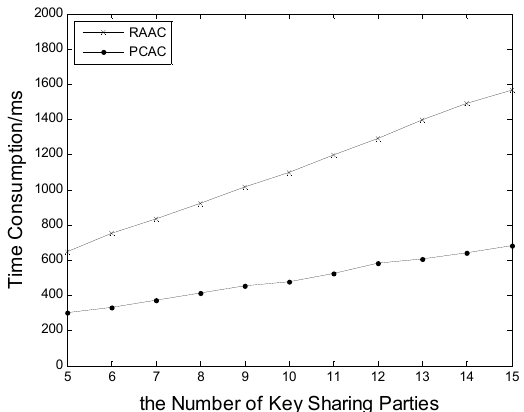
Figure 6. Time Consumption in the Data Obtainment Stage.